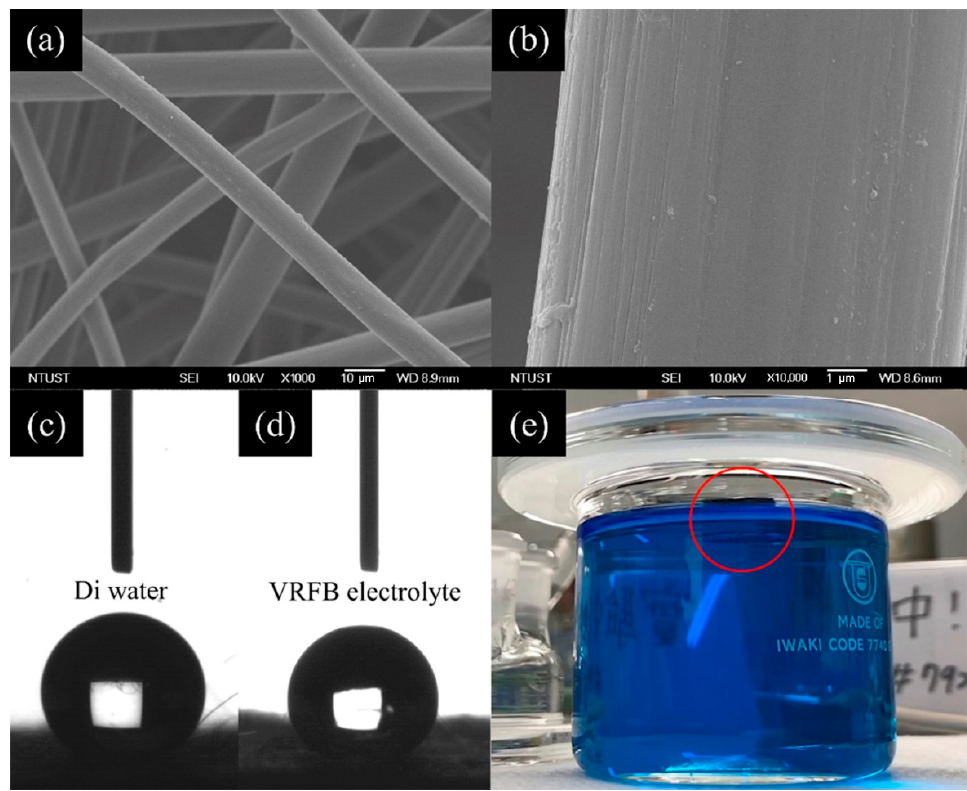
Figure 3. SEM images of pristine GF (a) × 1000 ( b ) ×10,000, and the contact angle measurements of pristine GF using ( c ) deionized water ( d ) VRFB electrolyte solution, and ( e ) a sinking test in VRFB electrolyte solution.